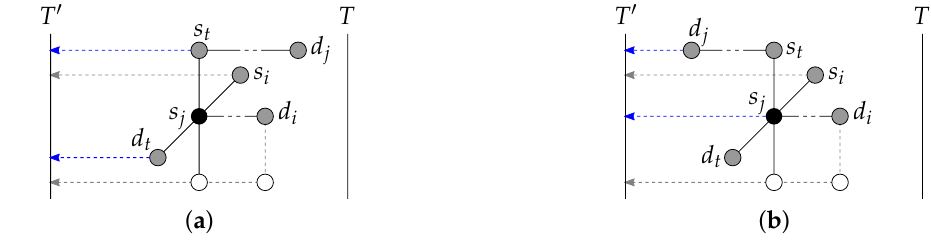
Figure 6. Illustration of the case n = c = 3 with the pair ( s i , d i ) blocking 3 paths for the pair ( s j , d j ) when routed to the subtorus T (cid:48) . Vertex s j is not routable to the subtorus T . ( a ) Pair ( s t , d t ) is routed to T (cid:48) in place of ( s i , d i ) . ( b ) Pair ( s t , d t ) is not routable to T (cid:48) (because of d j ), so pair ( s j , d j ) is routed to T (cid:48) in place of ( s i , d i )